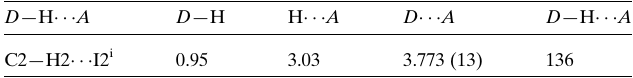
Figure 1 Reaction scheme for the preparation of the title